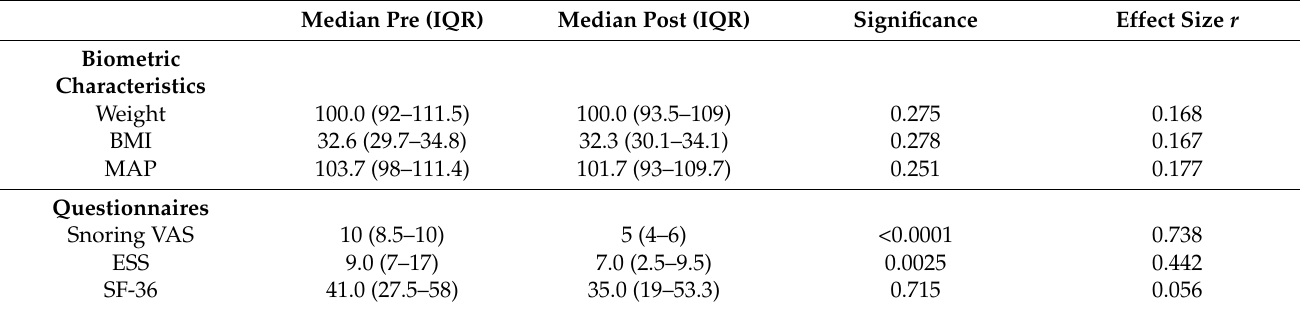
Table 2. Study outcome results.